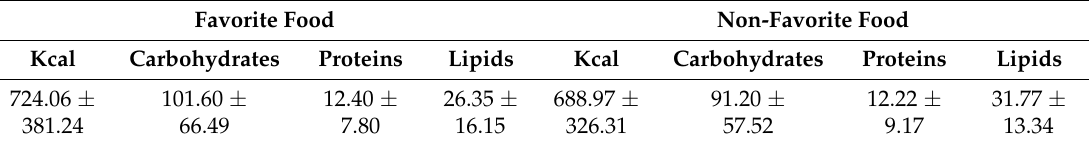
Table 1. Mean ( ± SD) calorie and nutrient contents (gram) of favorite and non-favorite foods eaten by